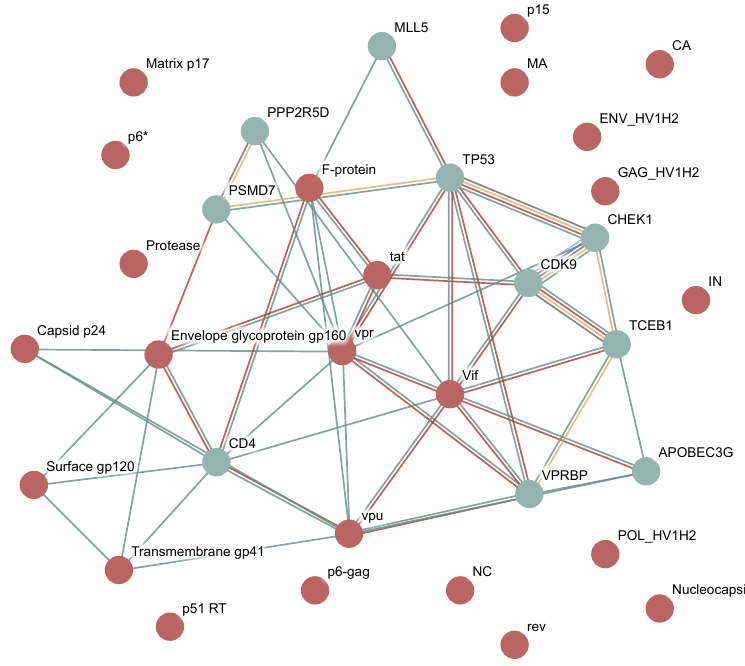
Figure 3. HIV-1 and Homo sapiens interaction network in viruses.STRING. HIV-1 and Homo sapiens interaction network downloaded as a vector image from viruses.STRING. The type of interaction is indicated by edge colour—green: text mining, red: experiments. Additional edge types can be found between host proteins, and come from the STRING database—yellow orange: pathway databases, light blue: protein homology, dark blue: gene co-occurrence, black: co-expression, light green: gene neighbourhoods, pink: gene fusions (last two not present in